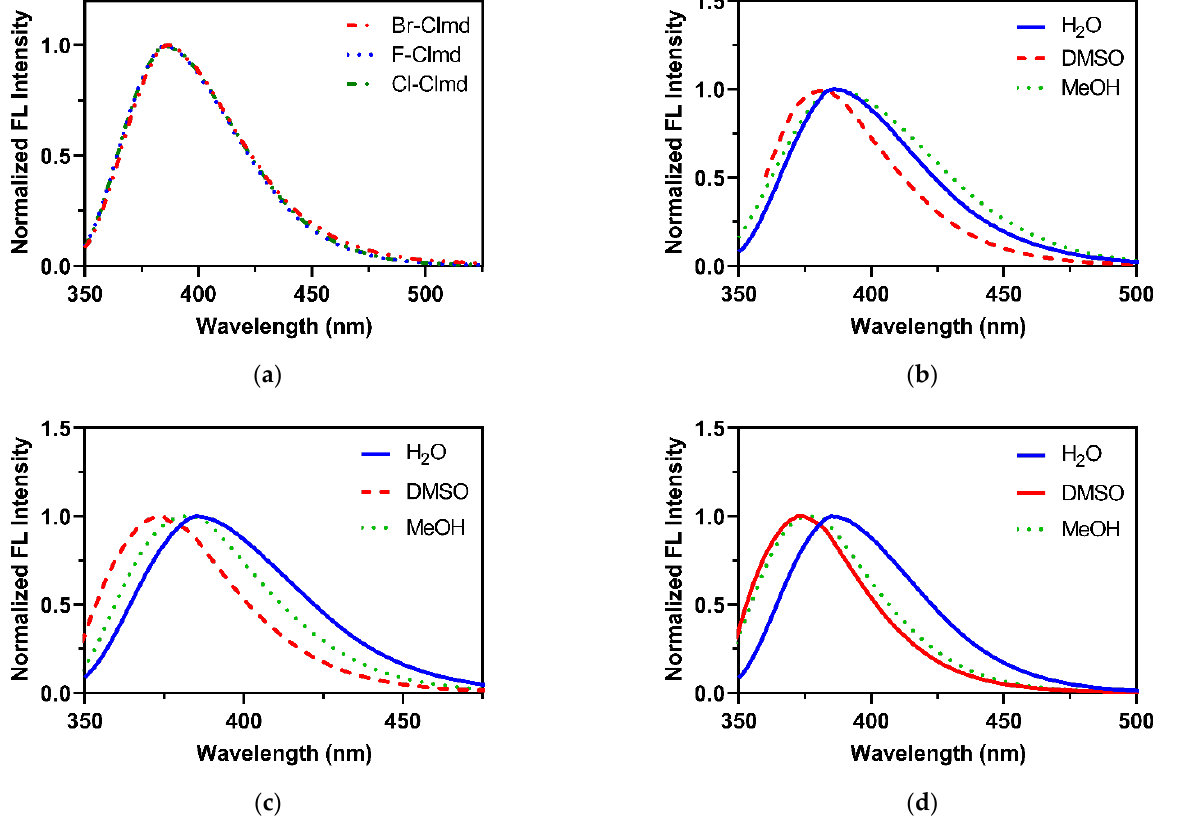
Figure 4. Normalized fluorescence (FL) spectra for the compounds studied in different solvents. ( a ) Halogenated Clmds in deionized water; ( b ) Br-Clmd; ( c ) F-Clmd; ( d ) Cl-Clmd. Excitation at 310